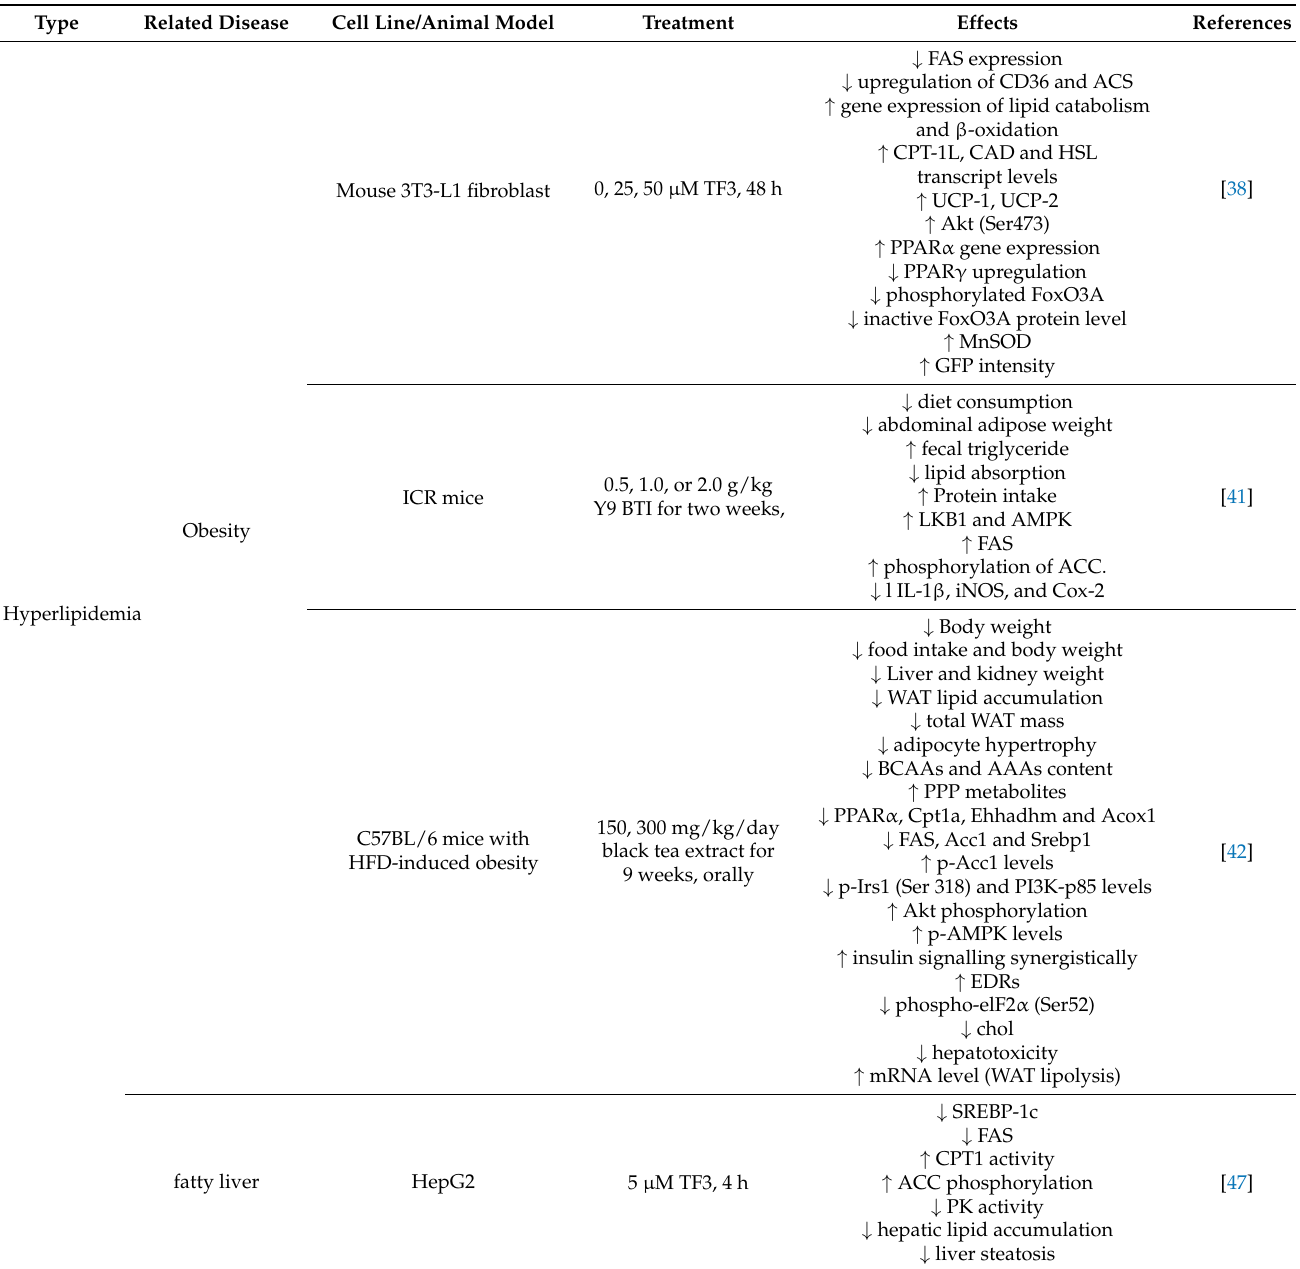
Table 1. Effects of theaflavins on diseases caused by metabolic abnormalities ( ↓ indicates down- regulation, ↑ indicates